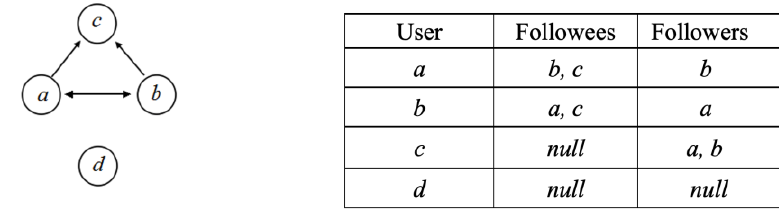
Figure 1. An abstract graph of social network.